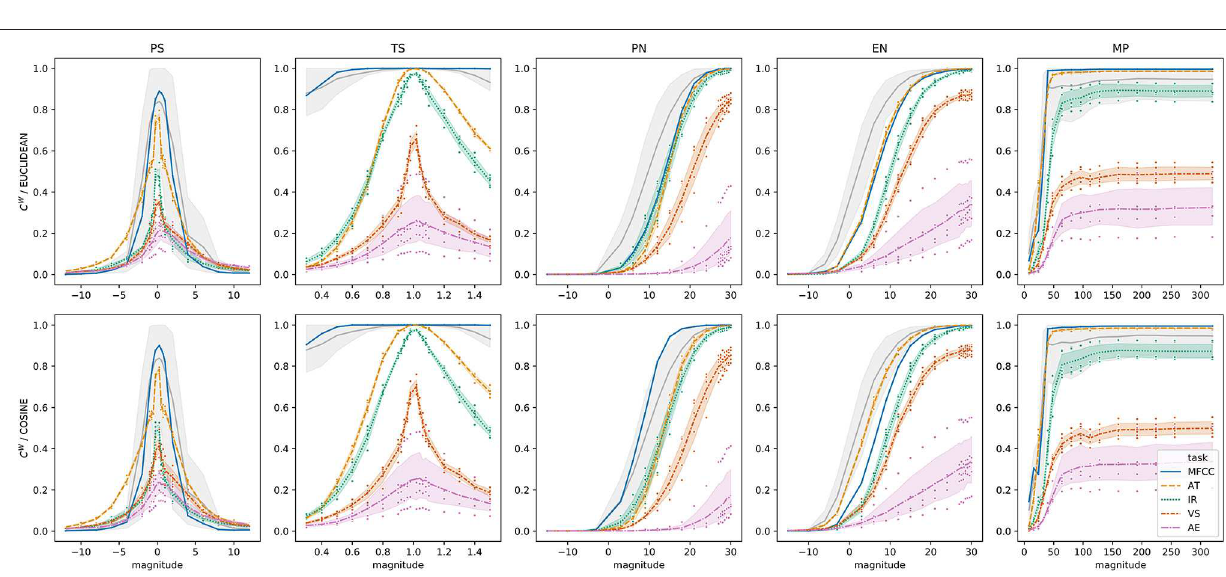
FIGURE 7 | Within-space consistency by transformation on the latent space L . Each curve indicates the within-space consistency C W by task and transformation. The gray curves indicate C W on A , taken as a weak upper bound for the consistency in the latent space. Confidence intervals are drawn at the 95% level. Points indicate individual observations from different